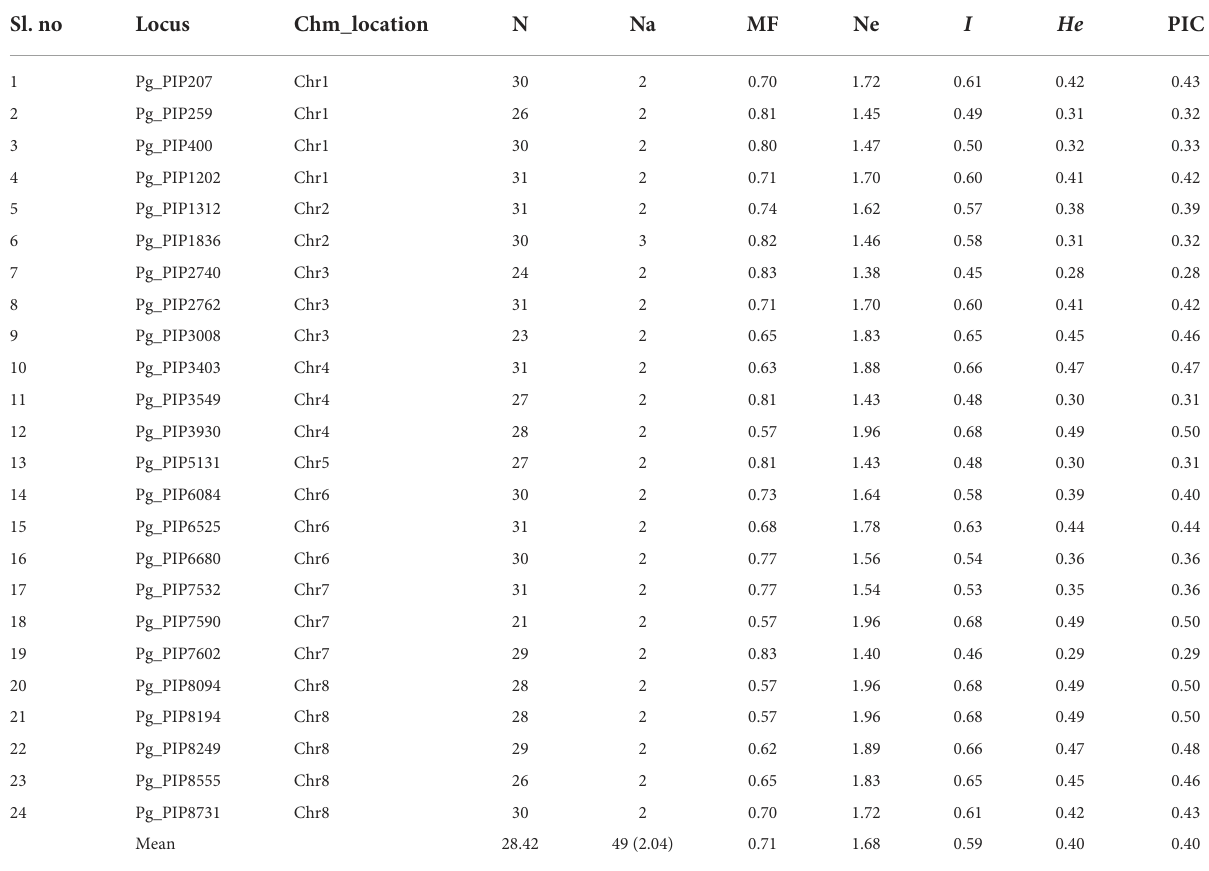
TABLE 5 Diversity parameters for 24 PIP markers screened on 31 pomegranate